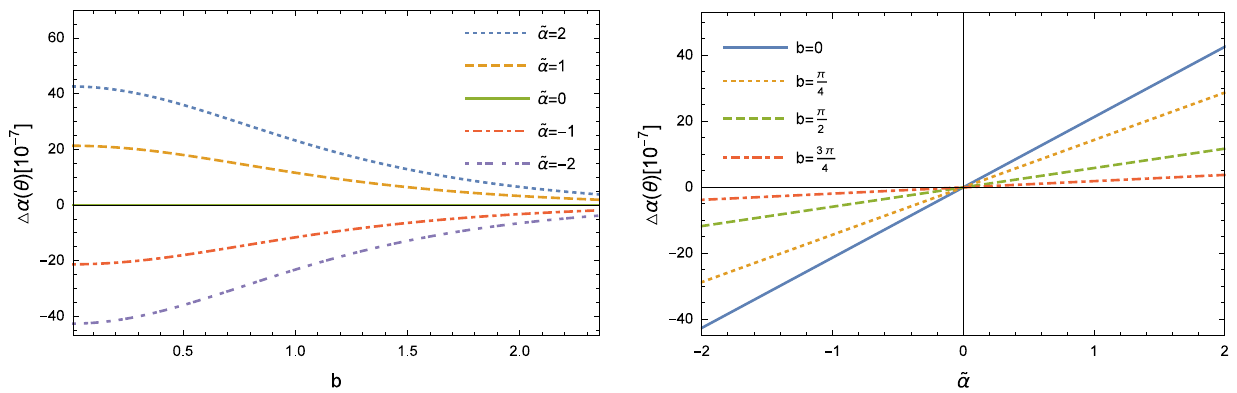
Fig. 3 Variation of the difference of the strong deflection limit coefficients (cid:15) ¯ a with phantom hair b (left) and coupling constant (cid:12) α (right) in the regular phantom black hole